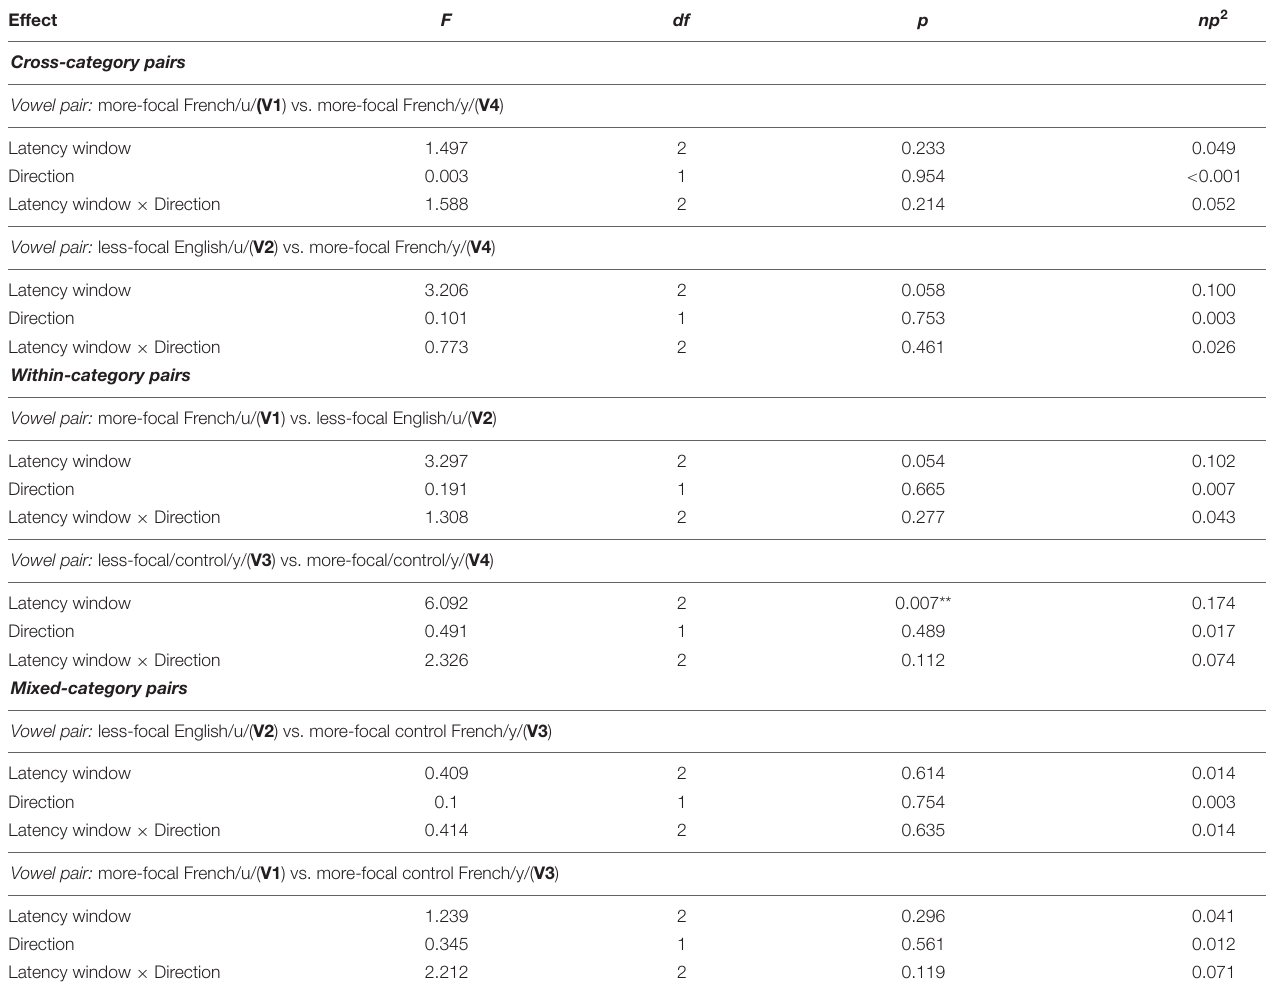
TABLE 2 | Repeated measures an analysis of variance (ANOVA) on mismatch negativities (MMN) amplitude presented for each stimulus type ( cross-category vs. within-category vs. mixed-category ). Effect F df p np 2 Cross-category